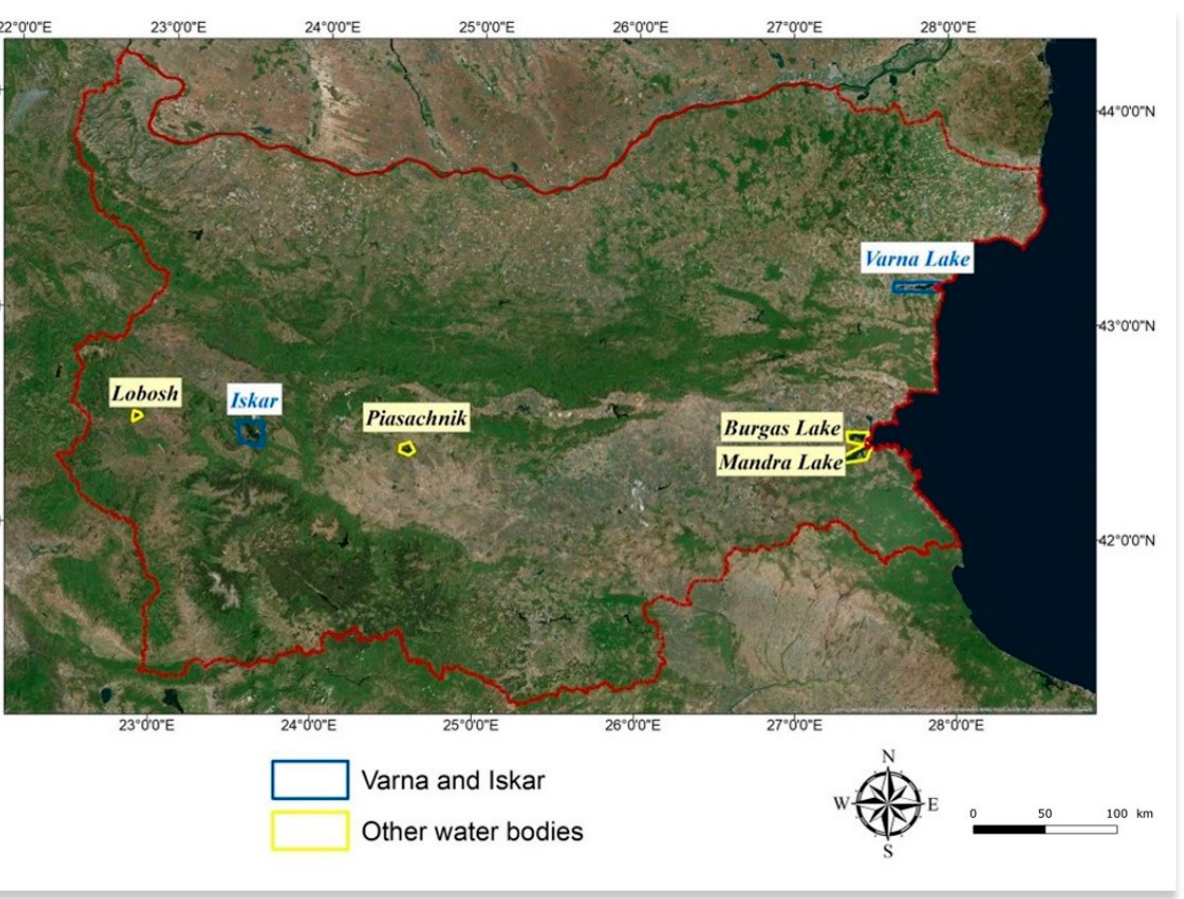
Figure 5. Varna Lake measurement stations of the standard monitoring reporting and the measured with field hyperspectrometer points in the EMOWAF project.